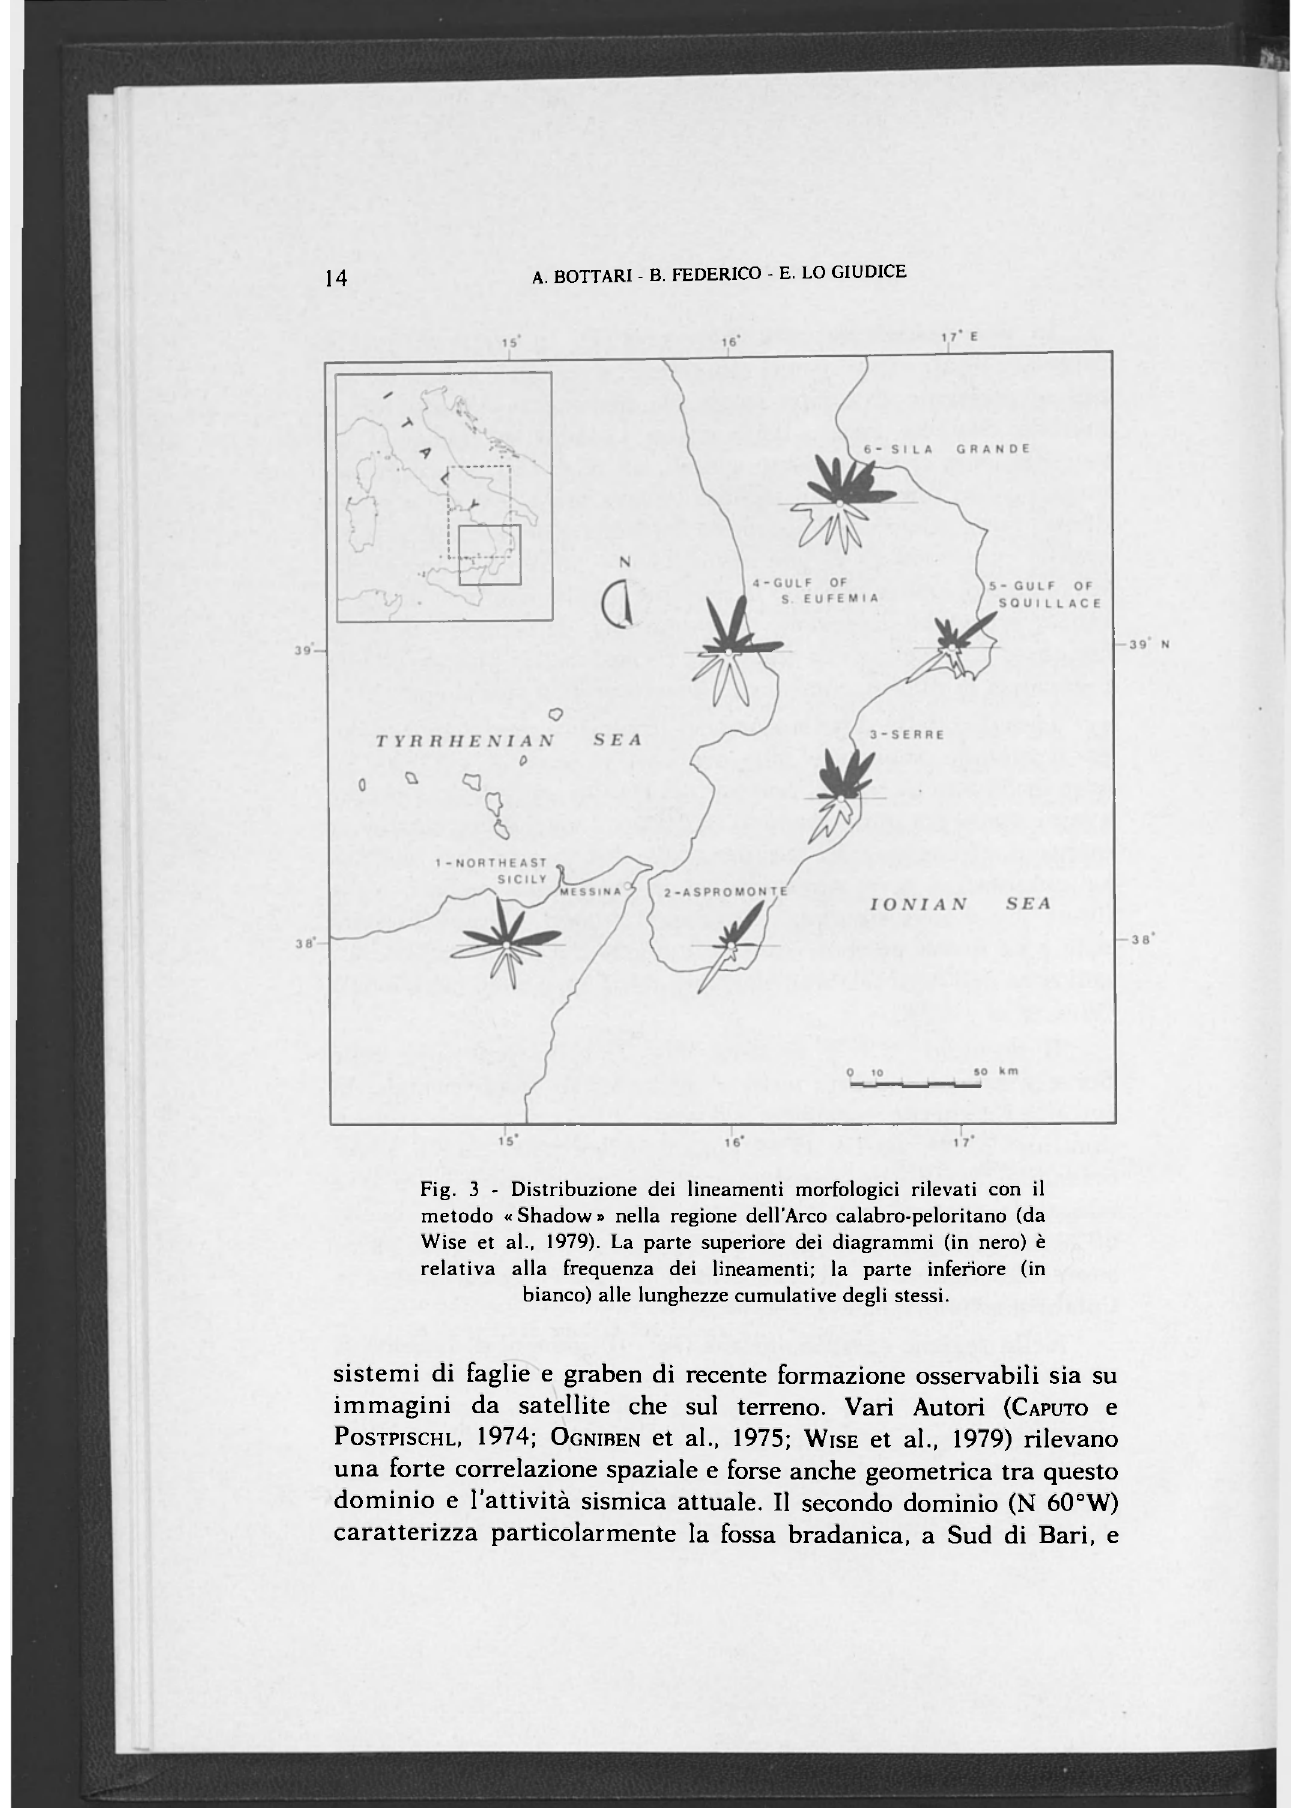
Fig. 3 - Distribuzione dei lineamenti morfologici rilevati con il metodo « Shadow » nella regione dell'Arco calabro-peloritano (da Wise et al., 1979). La parte superiore dei diagrammi (in nero) è bianco) alle lunghezze cumulative degli